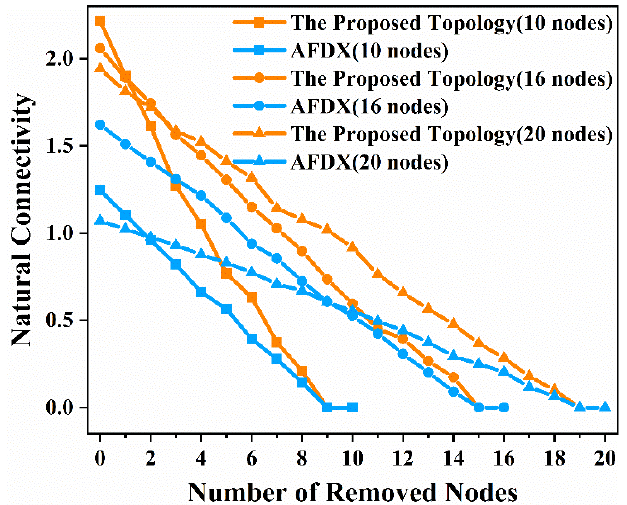
Figure 5. The comparison diagram of the natural connectivity of the proposed topology and AFDX with the number of removed nodes in the three scenarios.